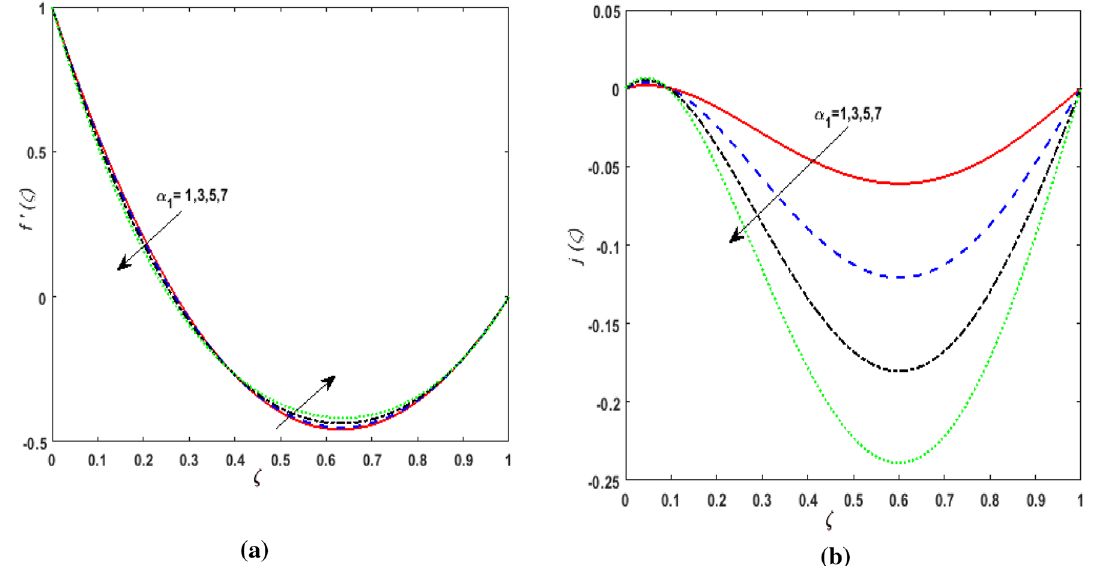
Figure 3. ( a ) Effect of rotation parameter α 1 on velocity f ′ (ζ) . ( b ) Effect of rotation parameter α 1 on velocity j (ζ) .